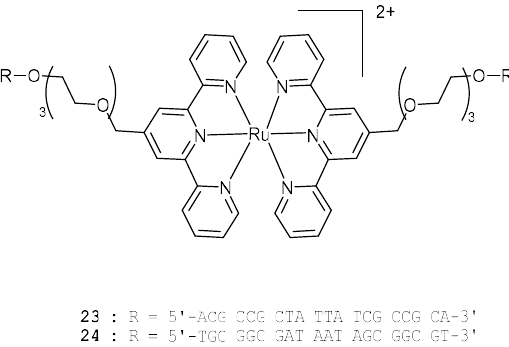
Figure 9. Structures of the Ru complex linked branched oligonucleotides 23 , 24 .